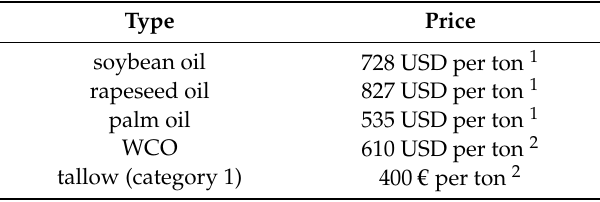
Table 4. The prices of the feedstocks [55,56].